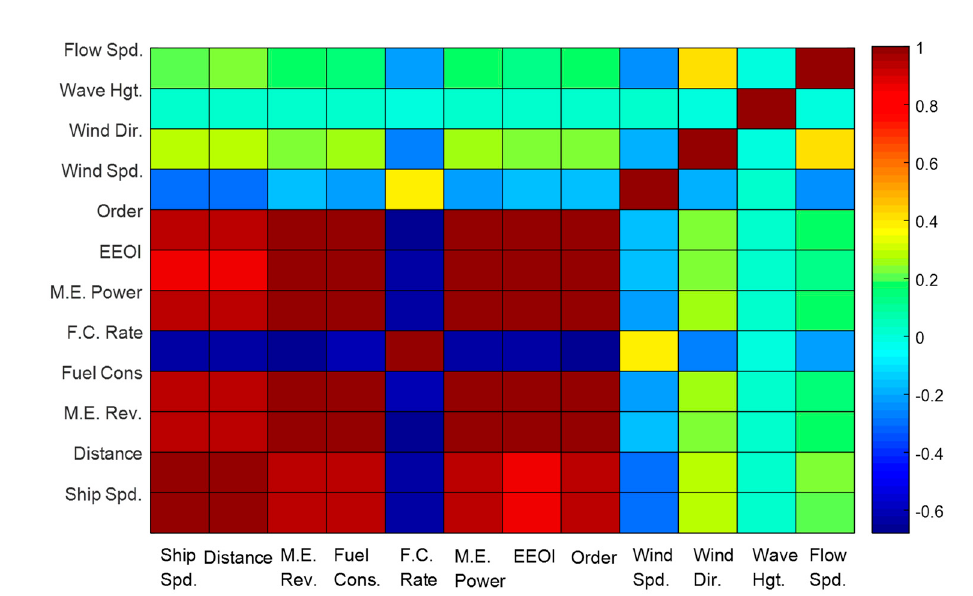
Figure 4. Data correlation diagram.